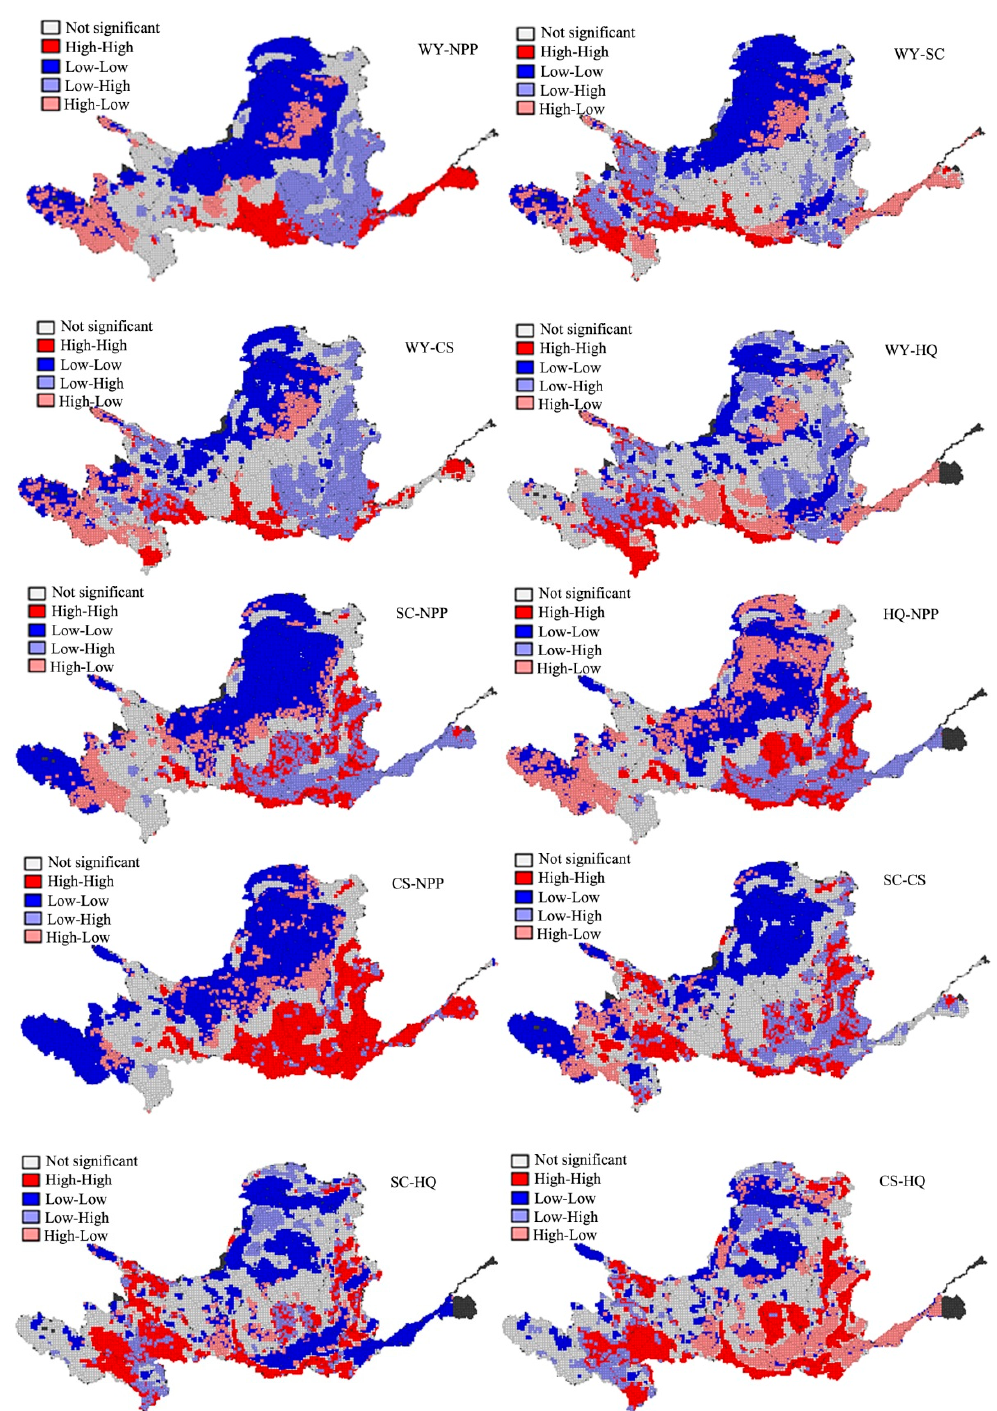
Figure 5. Schematic diagram of the coordination relationship space of the ESs of the Yellow River Basin. WY and CS show a trade-off relationship throughout the entire region. The two are in a synergistic relationship in a small amount of areas of the upper reaches of the Yellow River Basin, the middle reaches of Inner Mongolia, and the Ningxia Hui Autonomous Region. The low precipitation and low vegetation coverage in this area result in low CS and WY. The trade-off relationship is mainly distributed in the upper and middle reaches. In the upper reaches of the Bayan Har Mountains and Zhaling Lake, low-coverage grasslands are mostly distributed, with relatively low CS and high WY. In the middle reaches,